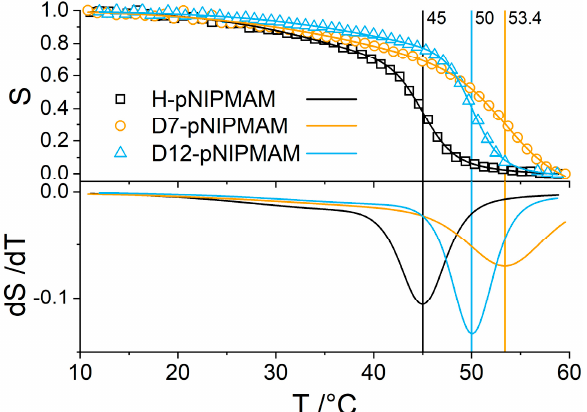
Figure 4. ( Top ) Swelling curves of pNIPMAM microgels in water with different levels of deuteration of the monomers. ( Bottom ) Derivative of the fit of the experimental data in the upper part. The vertical lines at the peaks indicate the VPTT of the respective microgel.